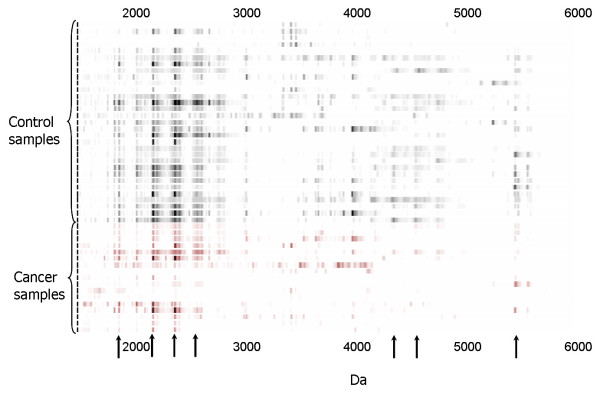
Expression difference map of gastric fluid on copper(II) immobilized metal affinity capture ProteinChip array (IMAC3). Arrows indicate protein biomarkers significantly different in expression level between the two groups of samples.